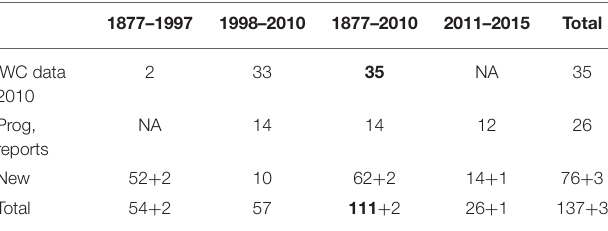
TABLE 1 | Summary of the number of unique Australian vessel strike reports ( + denotes extra reports where the witness identifies collision as “possible whale,” bold entries correspond the numbers used in the approximate comparison between Australia and world